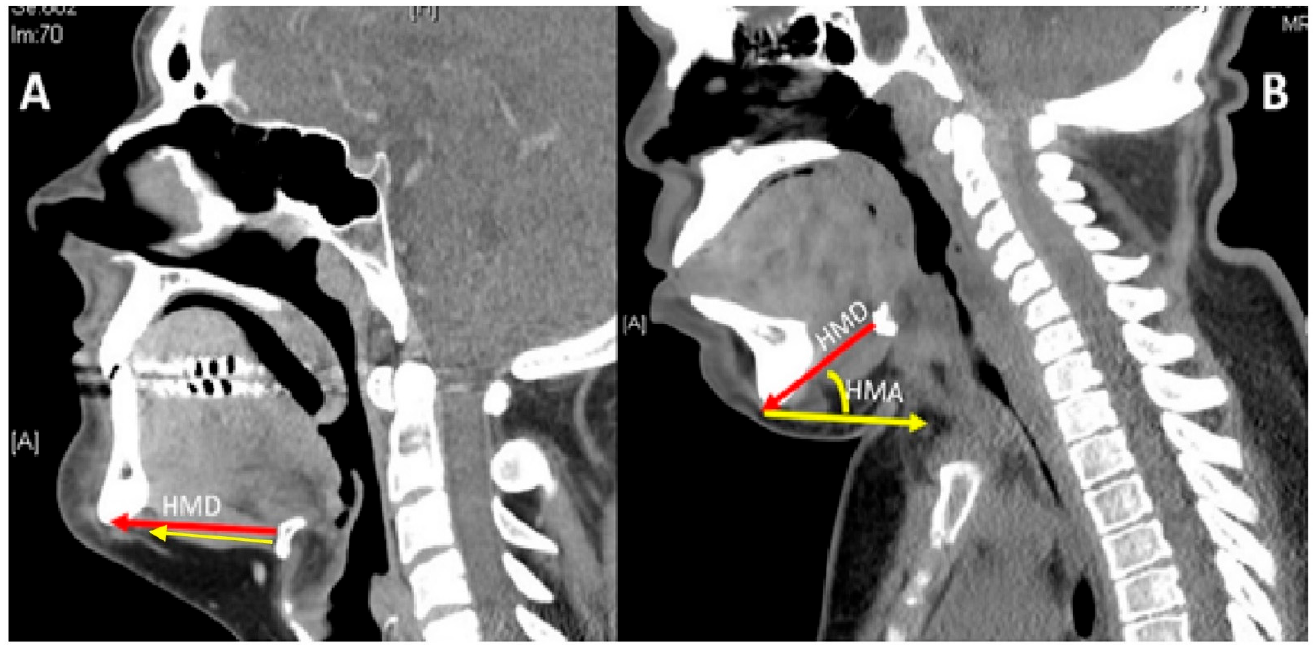
Figure 5. Shows the hyomental distance (HMD) and hyomental angle (HMA) in adult non-MPS marked ( A ) on the left and adult MPS patient marked ( B ) on the right, taken from a computer tomography (CT) scan of the neck in the neutral position. Red arrow represents the HMD and yellow arrow represents the horizontal.